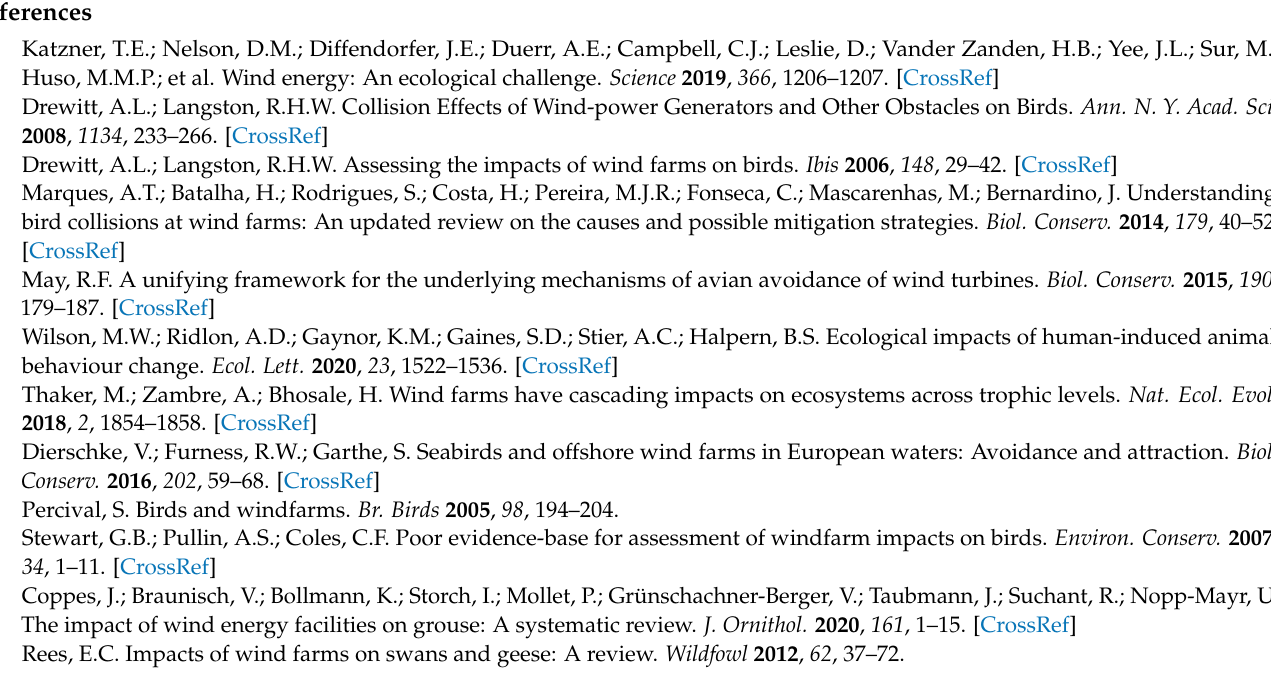
Figure A1. PRISMA flow chart of literature search and selection process.